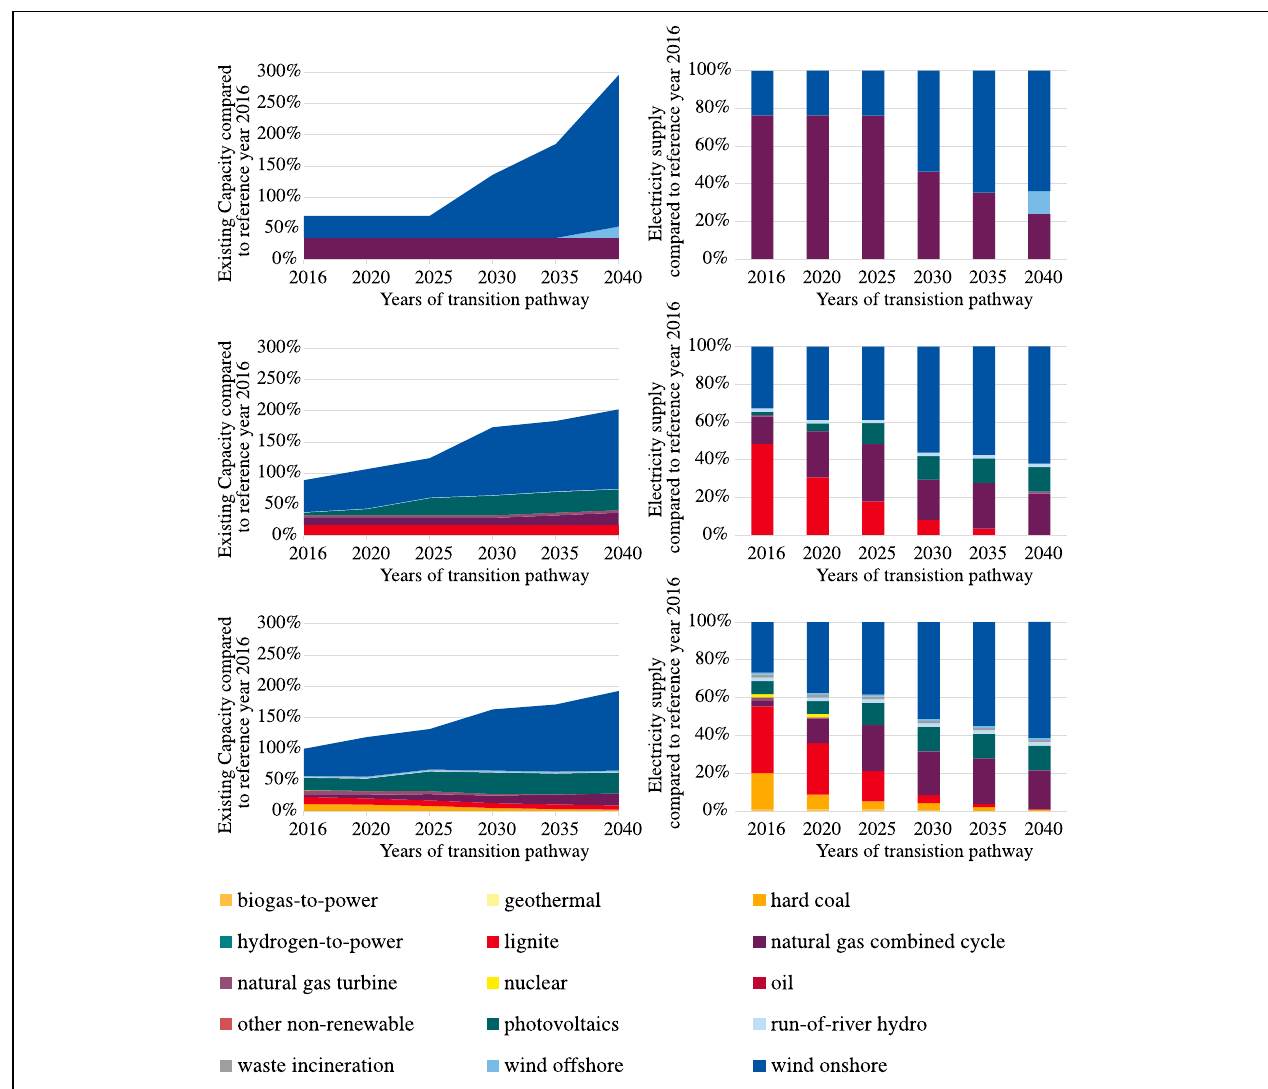
FIGURE 5 | Transition pathway of the German electricity sector until the year 2040 for three cases (Cases 1–3 in Table 3 from top to bottom). The left column shows the optimized production process capacity for electricity generation compared to the overall production process capacity in the reference case (Case 3, year 2016, as defined in Table 3 ). The right column shows the electricity production shares of the different production